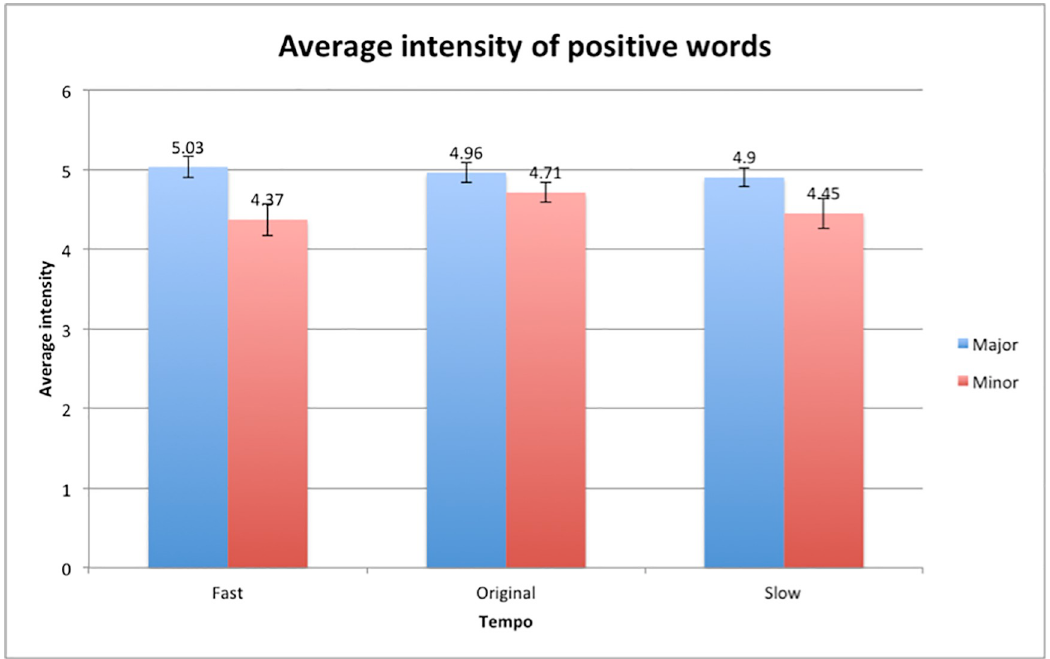
Fig 7. Average intensity rating of positive words in the major mode and minor mode conditions. Error bars indicate the standard error of the mean.